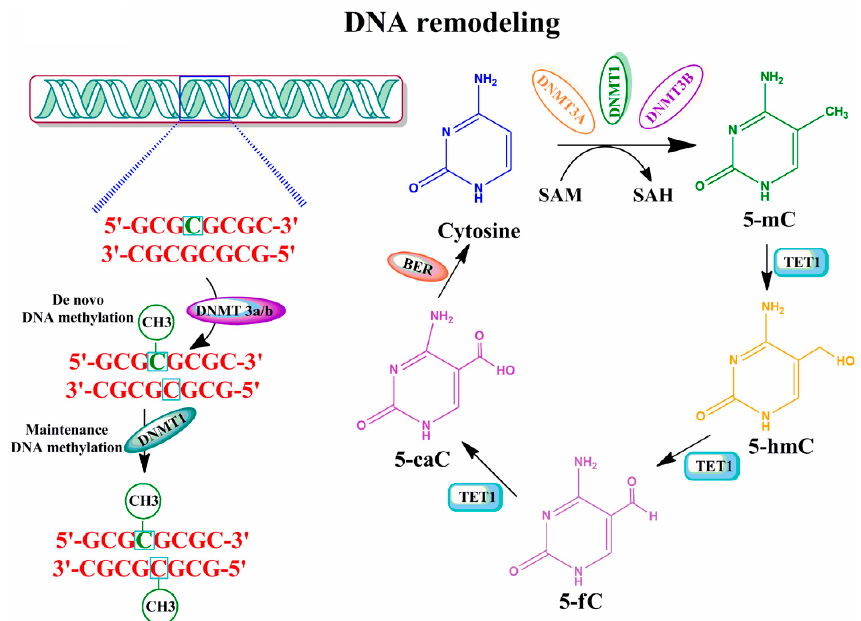
Figure 1. Graphic representation of DNA methylation and its regulation by enzymatic mechanisms. Methylation of DNA begins with the covalent addition of a methyl group from s-adenyl methionine (SAM) [41] to the fifth carbon of the cytosine pyrimidine ring to form 5-methylcytosine (5-mC), a process that is catalyzed by a family of DNA methyltransferases (DNMTs). The majority of DNA methylation usually occurs at genes on cytosines that precede a guanine nucleotide or CpG islands. De novo methyltransferases (e.g., DNMT3a/b) transfer methyl groups to naked DNA CpG pairs (e.g., CpG/GpC to mCpG/GpC) [42,43]. DNMT1 is the maintenance methyltransferase that transfers methyl groups to hemimethylated DNA strands (e.g., mCpG/GpC to mCpG/GpCm) and maintains the parental DNA methylation pattern during replication [44]. 5-mC undergoes sequential oxidation to 5-caC by TET1 activities. 5-caC, through base-excision-repair (BER) mechanisms, results in the regeneration of cytosine [39,45,46]. 5-methylcytosine (5-mC); 5-hydroxymethylcytosine (5-hmC); 5-formylcytosine (5-fC); 5-carboxylcytosine (5-caC).